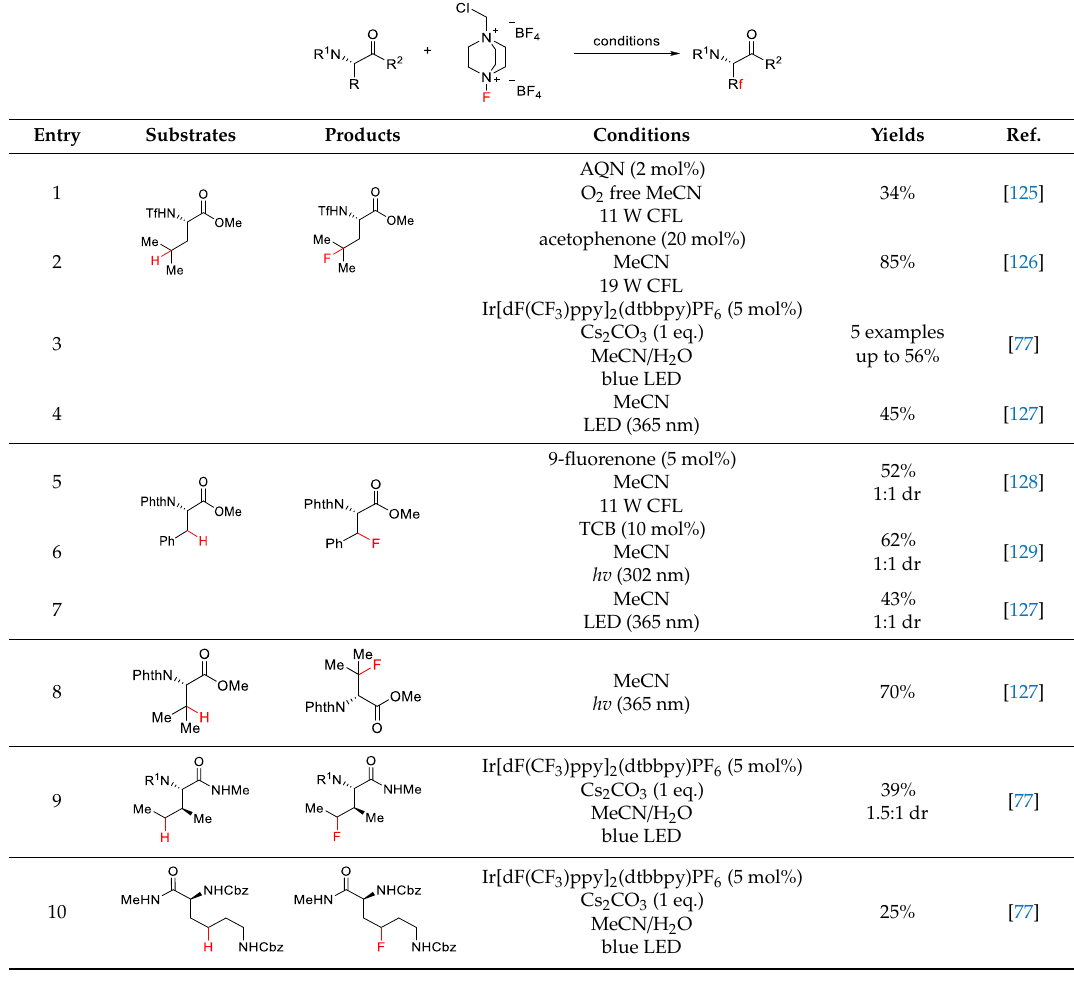
Table 1. C(sp 3 )–H fluorination of amino acids with Selectfluor. Entry Substrates Products Conditions Yields